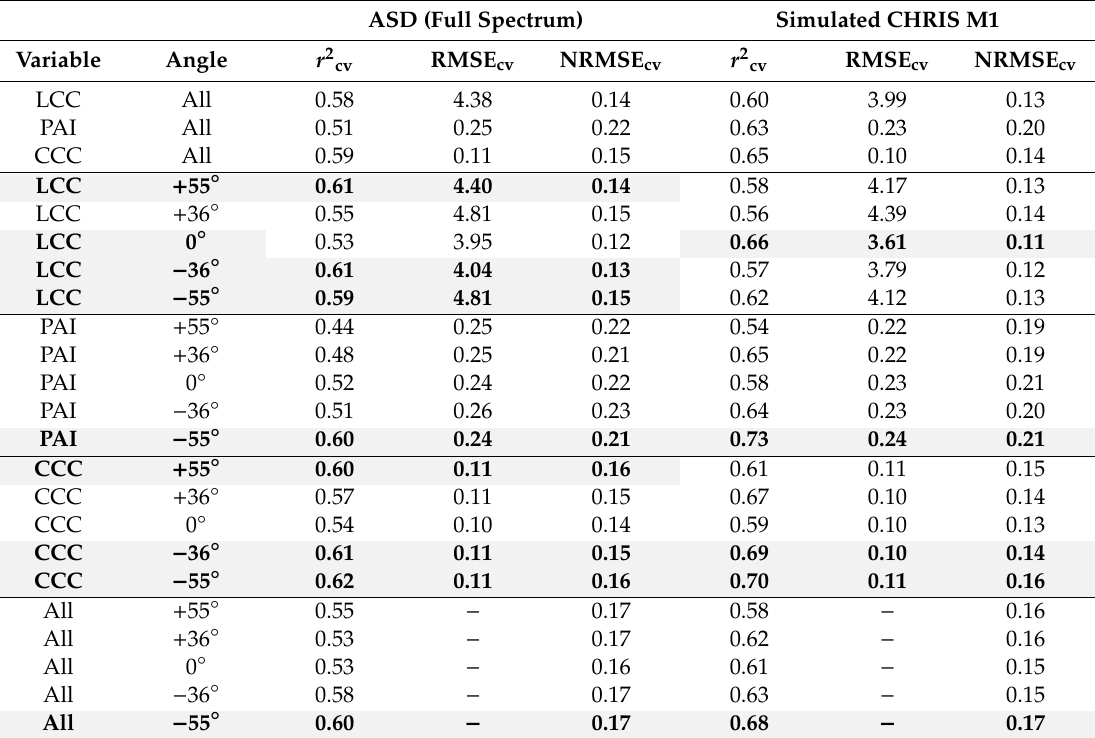
Table 6. GPR model performance for plot scale data averaged over all sites and VZAs. RMSE cv units: LCC ( µ g / cm 2 ); PAI (unitless); CCC (g / m 2 ). NRMSE cv = RMSE cv / range of measured data. The top angle-based results are highlighted and